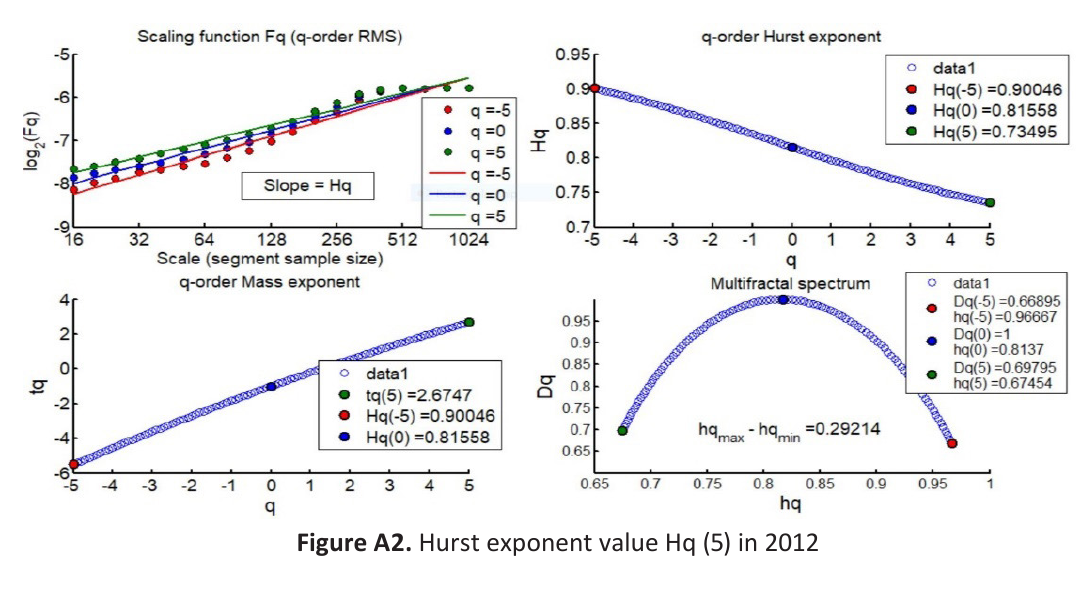
Figure A1. Hurst exponent value Hq (5) in 2011